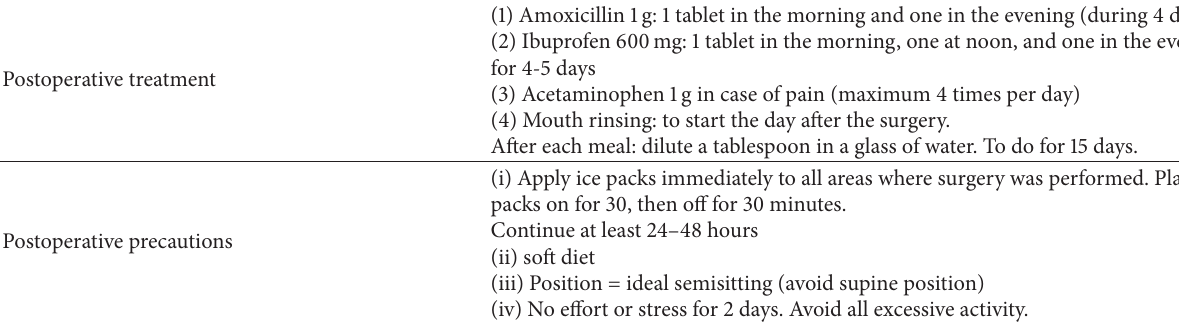
Table 3: Postoperative recommendations distributed to patient after